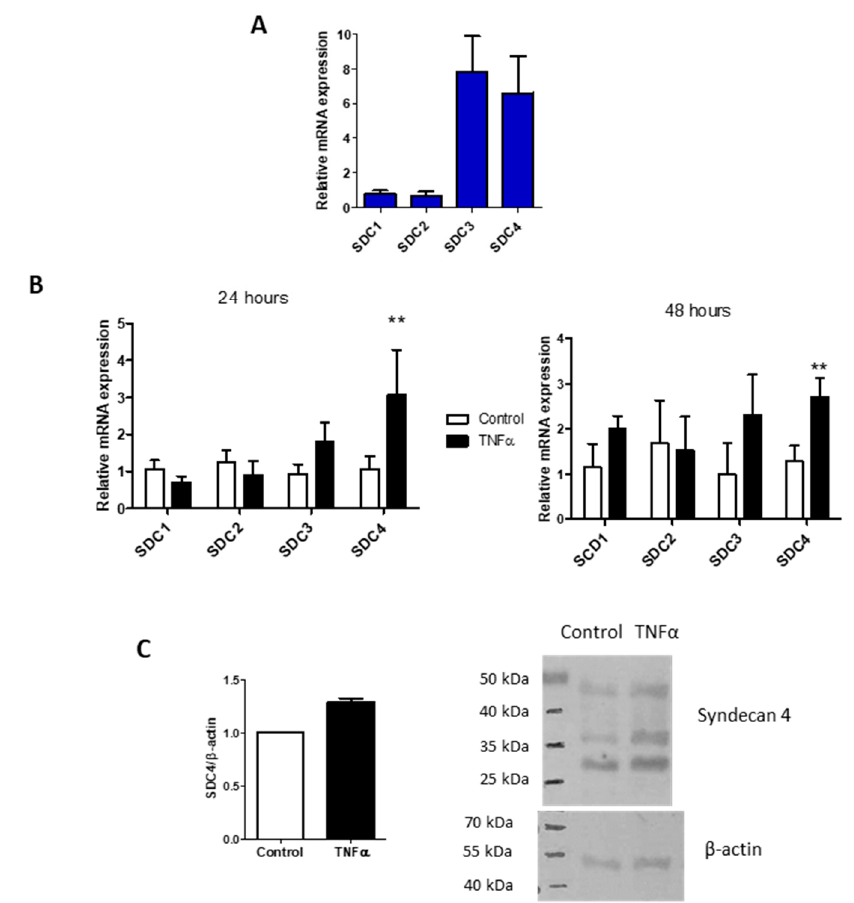
Figure 3. TNF- α influence on Syndecans expression. ( A ) Syndecans expression profile in HUVEC. The reference gene used for normalization was β -actin and the normalizer the Syndecan-1 expression level. ( B ) Syndecans isoforms expressions in HUVEC control and after 24- and 48-h of TNF- α stimulation. The reference gene used for normalization was β -actin and the normalizer untreated samples. Values represent mean ± S.E.M. (n = 3), ** p < 0.01. ( C ) Western blot analysis of Syndecan-4 (SDC4) protein in HUVEC control and treated 24 h with TNF- α . Bar chart represents normalized mean ± S.E.M. of two independent experiments and the figure is a representative